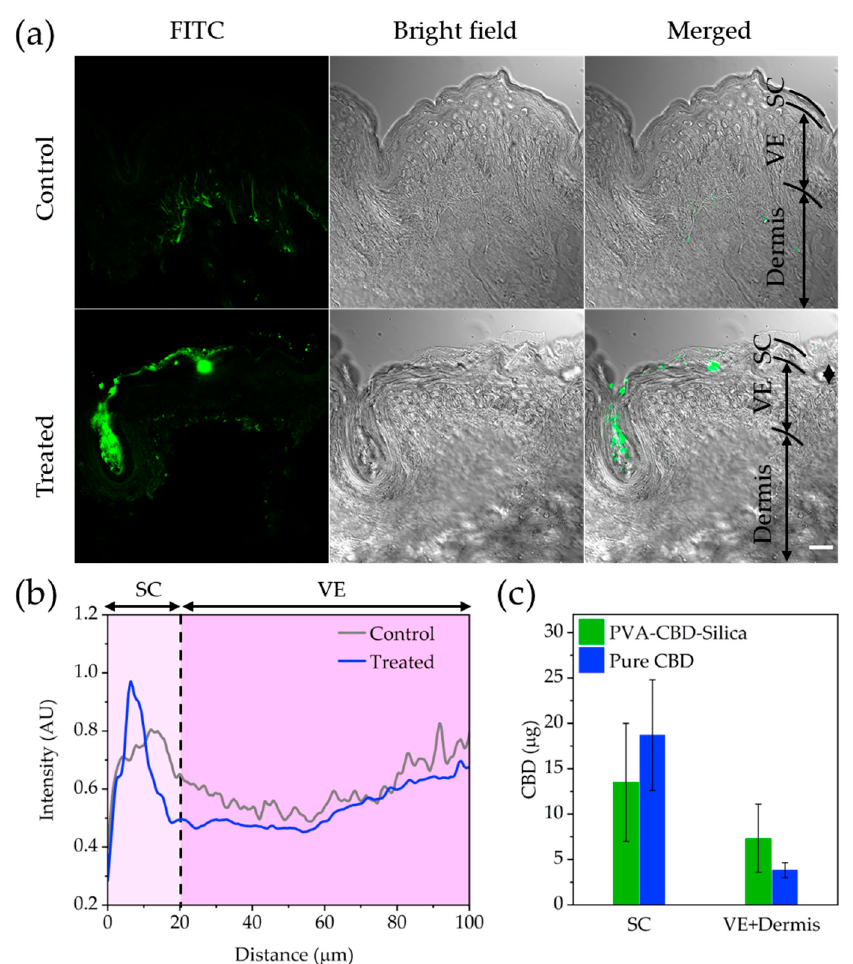
Figure 6. ( a ) Human skin penetration of PVA-FITC-Silica. LSCM imaging of cross-sectioned untreated control (first panel) and treated human skin with PVA-FITC-Silica (second panel) after 72 h exposure. Left, middle and right columns show green pseudo-coloured (FITC), bright-field and merged microscopy channels, respectively. Scale bar, 20 µ m. ( b ) Penetration profiles of PVA-FITC-silica in control and treated human skin. ( c ) Total CBD concentrations measured in different layers of human skin treated with either pure CBD or PVA-CBD-silica. The stratum corneum, viable epidermis and dermis layers of skin are designated as SC, VE and Dermis, respectively.